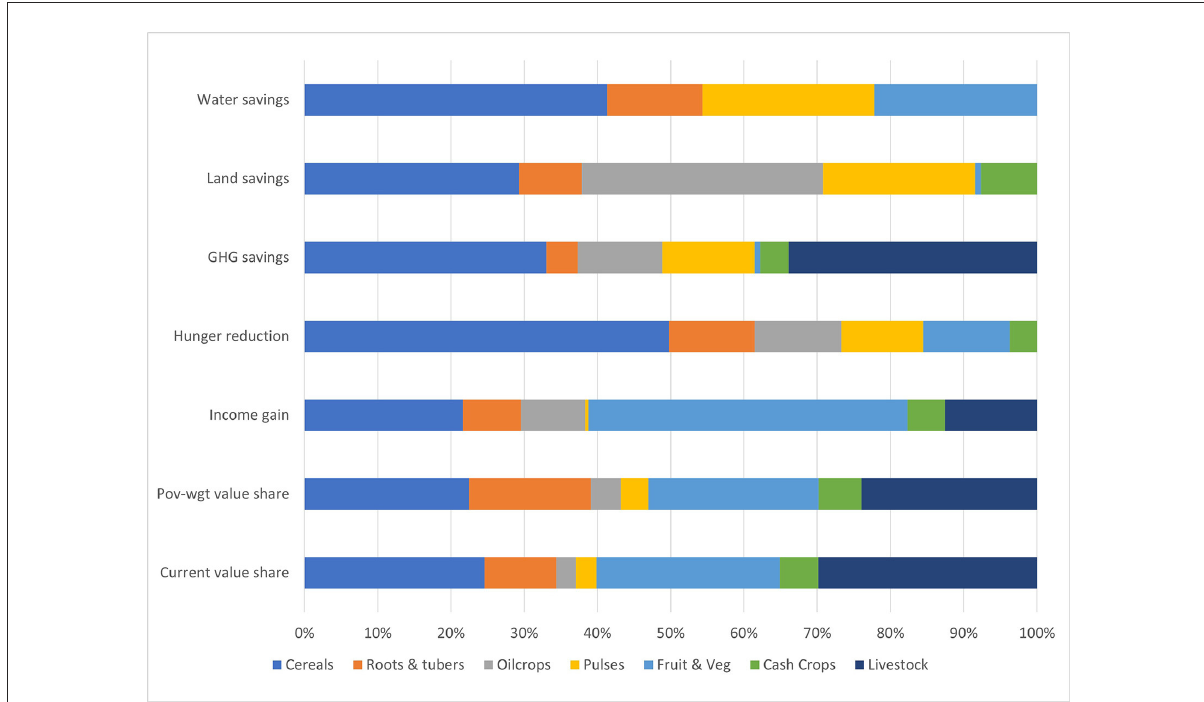
FIGURE2 R&D allocation parity rule from commodity productivity increases. The parity rule is to allocate R&D in proportion to anticipated benefits or positive impacts. The colors of the bar chart show the relative size of the impacts from productivity growth in the respective commodity groups. The R&D allocation across commodities implied by the parity rule varies depending on policy preferences over type of impact. The figure draws from the estimates reported in Table